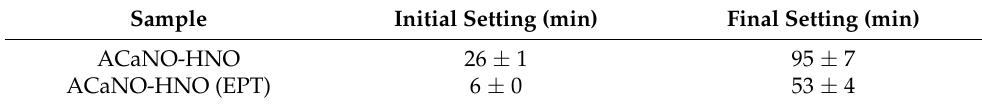
Table 3. Initial and final setting times measured for the sol – gel BEC samples.